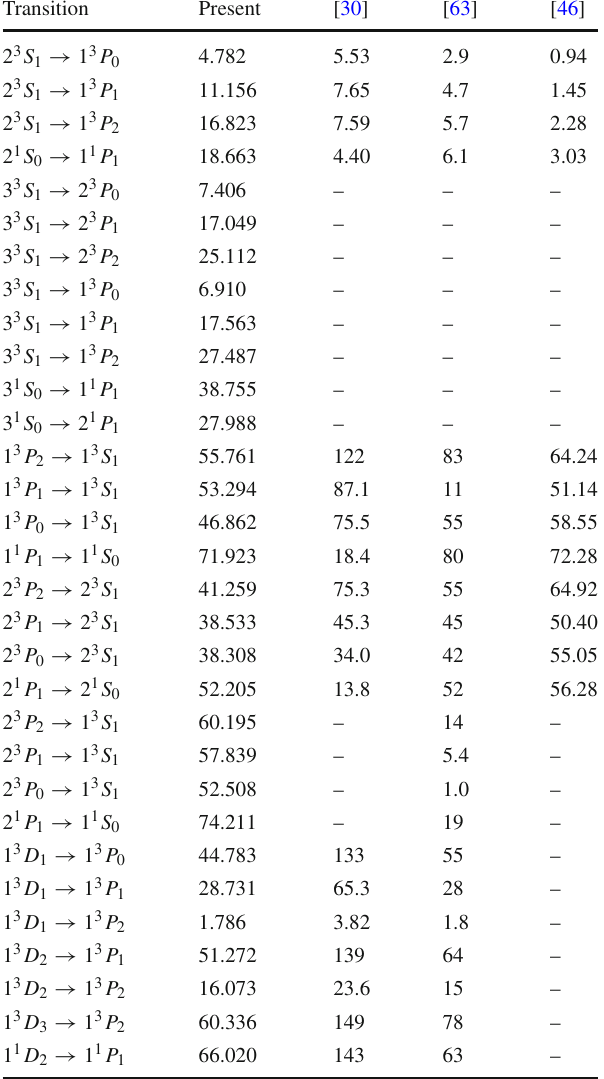
Table 23 M 1 transition width of charmonia (in keV) Transition